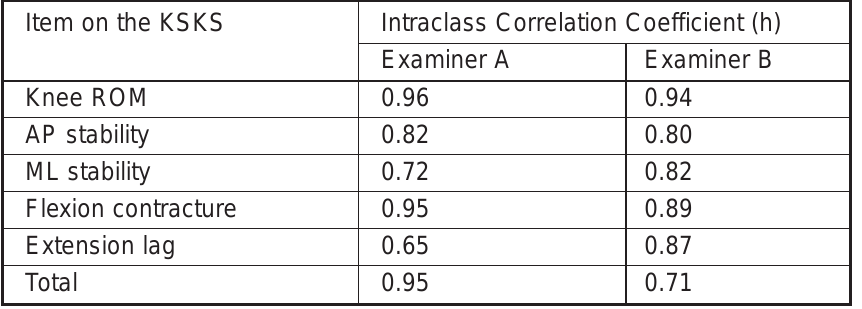
Table 2: The Intraclass Correlation Coefficient of intra rater reliability